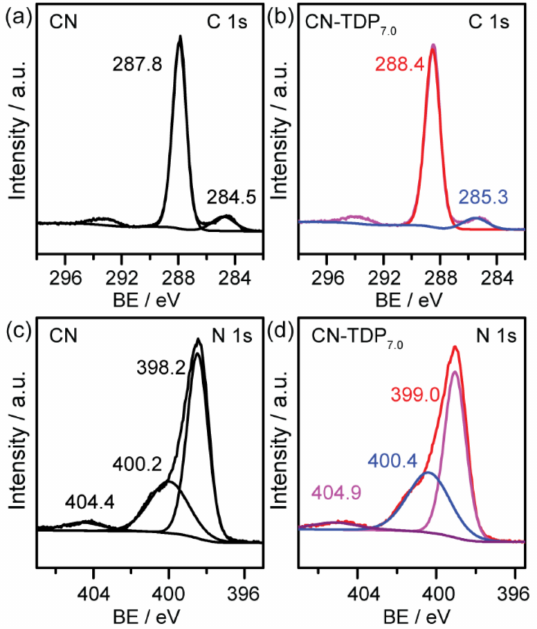
Figure 4. High-resolution XPS spectra of CN and CN-TDP 7.0 . ( a – b ) for C 1s and ( c – d ) for N 1s,